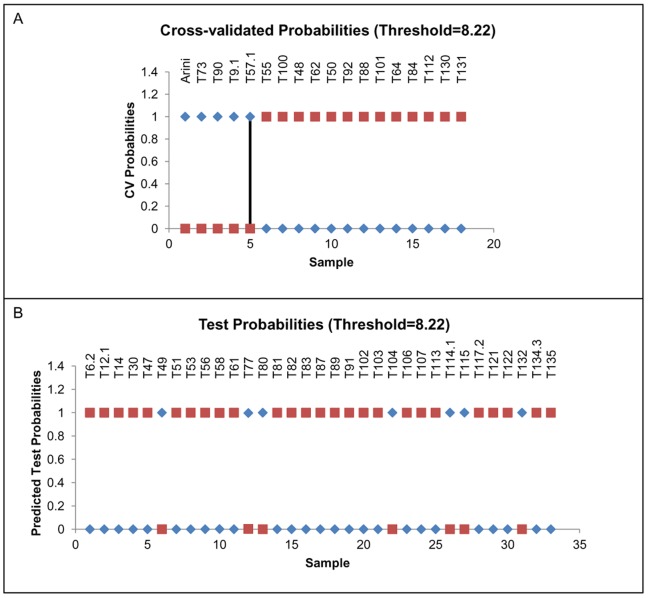
Class prediction analysis.Plot of cross-validated probabilities and test probabilities for sample classification. (A) On x-axis individual reference samples: 1–5 undifferentiated mast cell tumor samples, 6–18 differentiated mast cell tumor samples; on y-axis the probability of being classified as undifferentiated (blue rhombus) or differentiated (red squares). (B) On x-axis individual unknown samples; the probability of being classified as undifferentiated (blue rhombus) or differentiated (red squares).